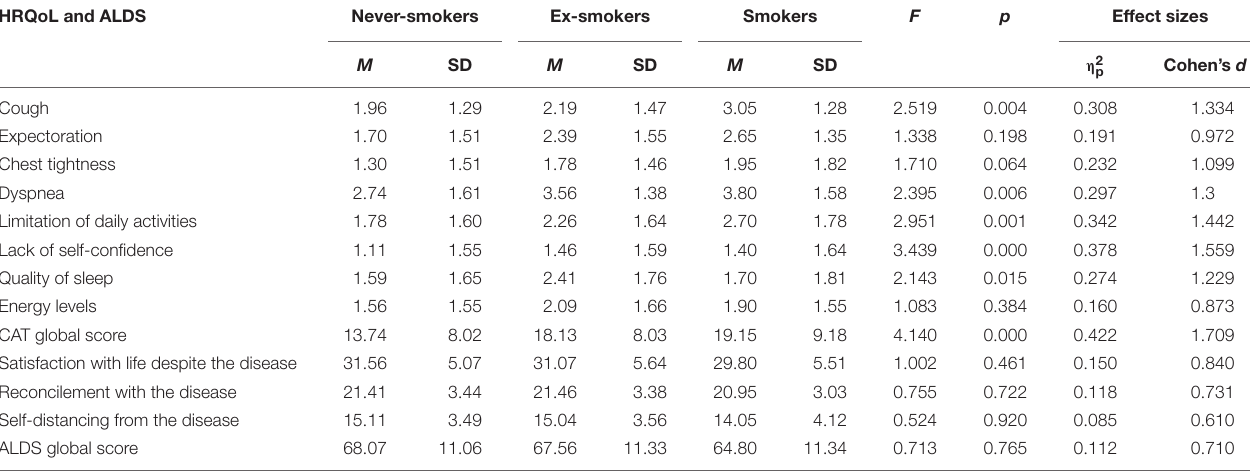
TABLE 2 | Differences between groups distinguished on the basis of smoking status.